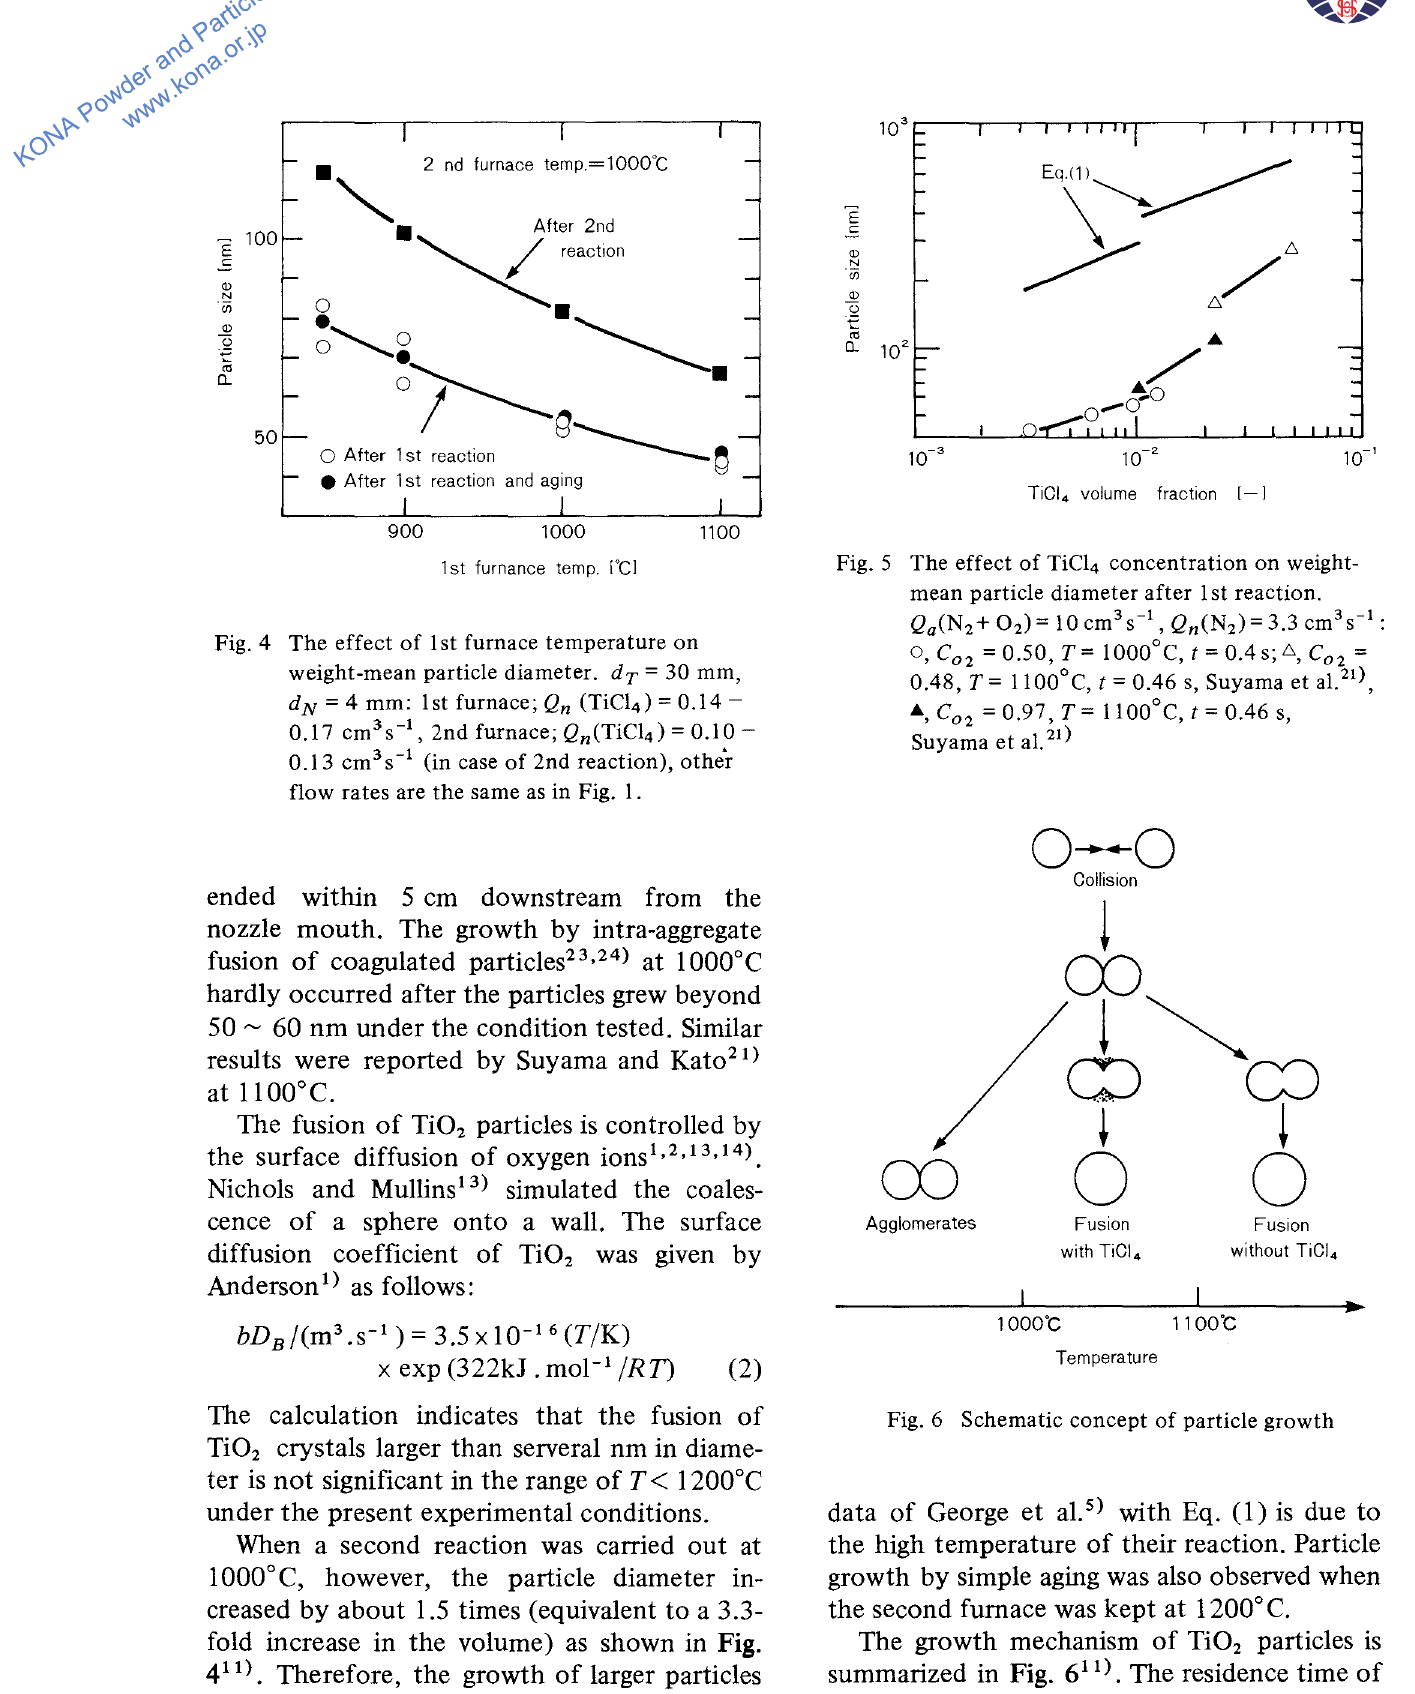
Fig. 6 Schematic concept of particle growth